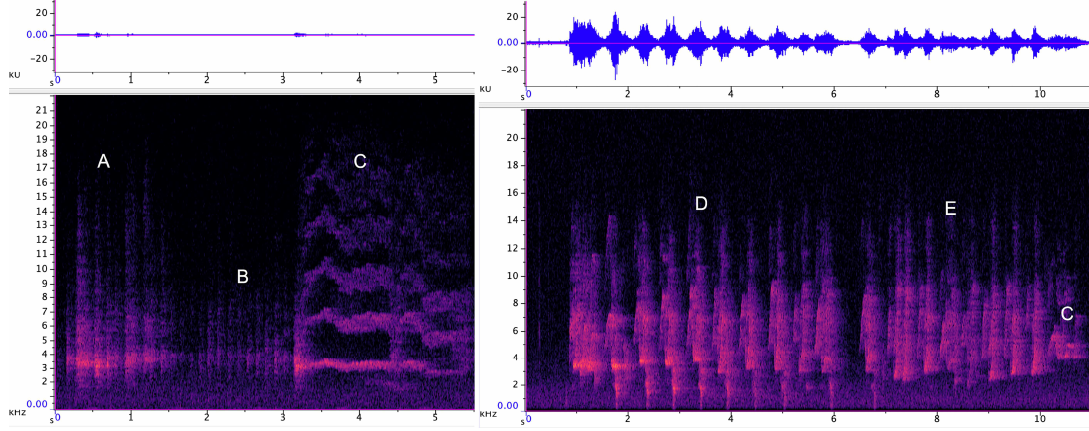
Figure 6. Dendrohyrax song syllables (upper images: waveform, lower images: spectrogram). The spectrogram on the left shows the first 5.5 s of a 30 s long sequence (Sound S11), and the spectrogram on the right shows the 10 first seconds of a 32 s long sequence (Sound S12). ( A ) Cracle is a short, (1.5 s), vertical broadband pulse with 10 subunits, and is often used in association with rachet. ( B ) Rachet is a short 1.2 s long call with 11 tightly packed subunits, and is often used in association with cracle. ( C ) Wheeze sounds like whistle, here with five harmonics. Wheeze is often used without other call-types in a longer sequence, or is added into songs during any phase. Wheeze element may also be added to strangled thwack. ( D ) Chuck is a tightly packed phase of 10 subunits. ( E ) Chirp is a packed phase here consisting of nine tightly packed subunits. Here chirp is followed by one